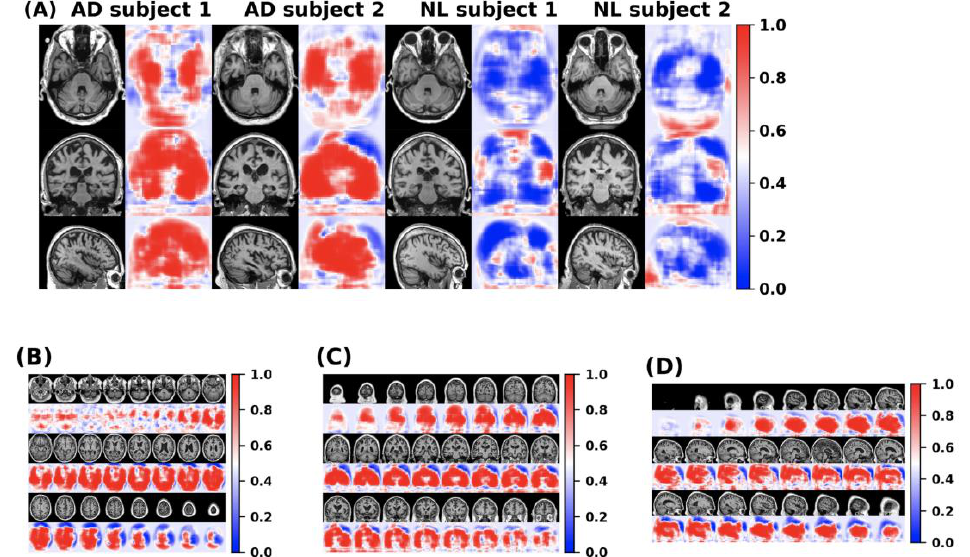
Figure 11. ( A ) The disease probability map generated by the FCN model highlights the brain regions at high risk of Alzheimer’s disease. The first two samples were clinically diagnosed as patients with Alzheimer’s disease, and the latter two samples were clinically confirmed as normal cognitive persons. ( B – D ) shows the axial, coronal and sagittal disease probability map of patients who are clinically diagnosed with Alzheimer’s disease. Red indicates that the risk of Alzheimer’s disease is > 0.5, and blue indicates < 0.5.